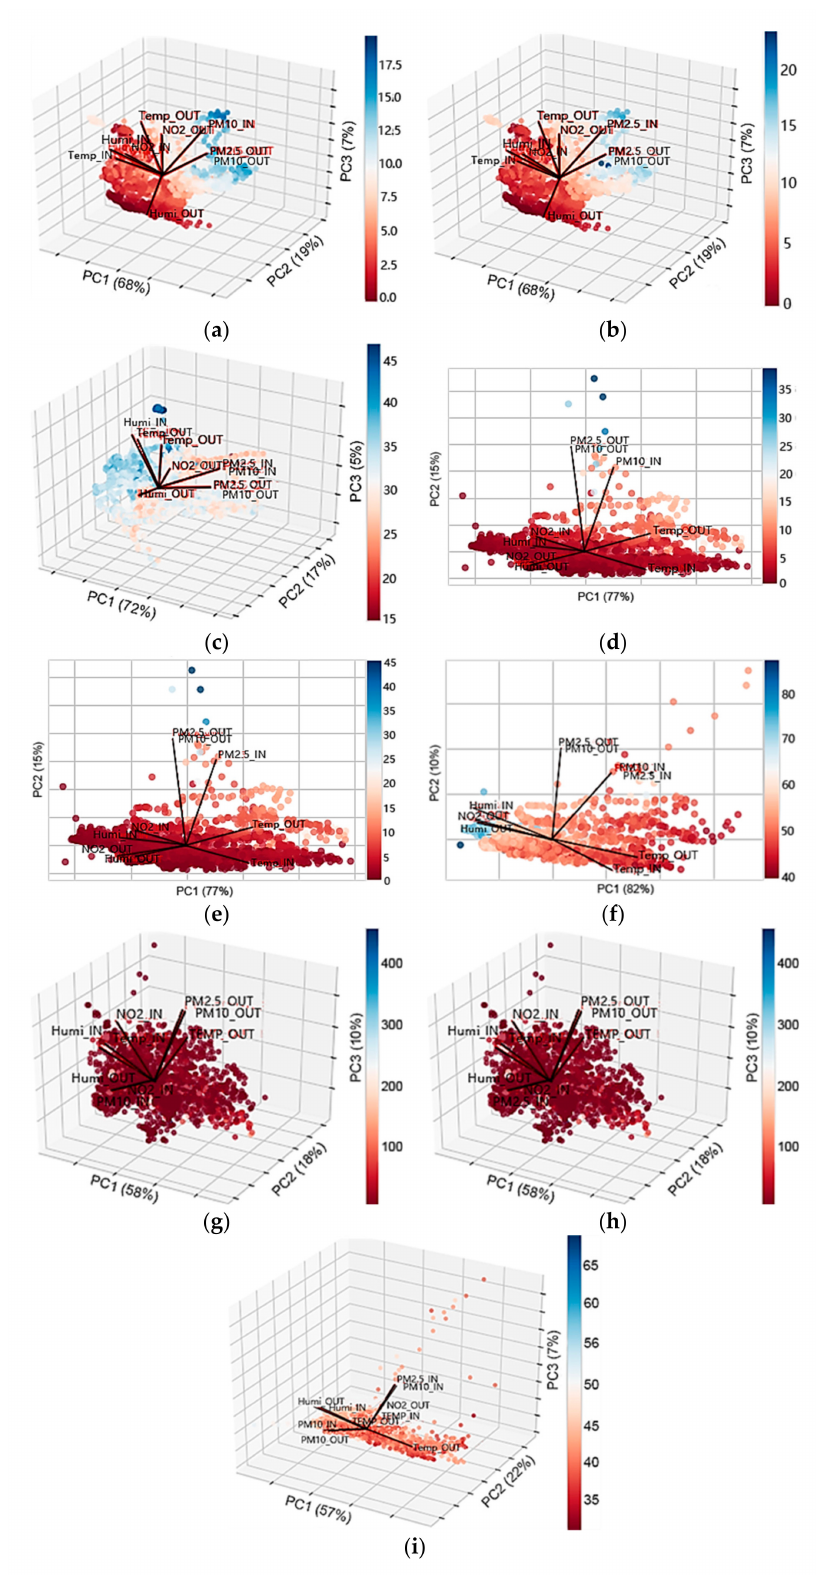
Figure 5. PCA-based biplot of indoor–outdoor data: ( a ) Site 1-PM 2.5 , ( b ) Site 1-PM 10 , ( c ) Site 1-NO 2 , ( d ) Site 2-PM 2.5 , ( e ) Site 2-PM 10 , ( f ) Site 2-NO 2 , ( g ) Site 3-PM 2.5 , ( h ) Site 3-PM 10 , ( i ) Site 3-NO 2 . With calibrated axes and observations as scatters. The color bar represents the values of the dependent variable (target pollutant). The direction of eigenvectors is represented as solid red